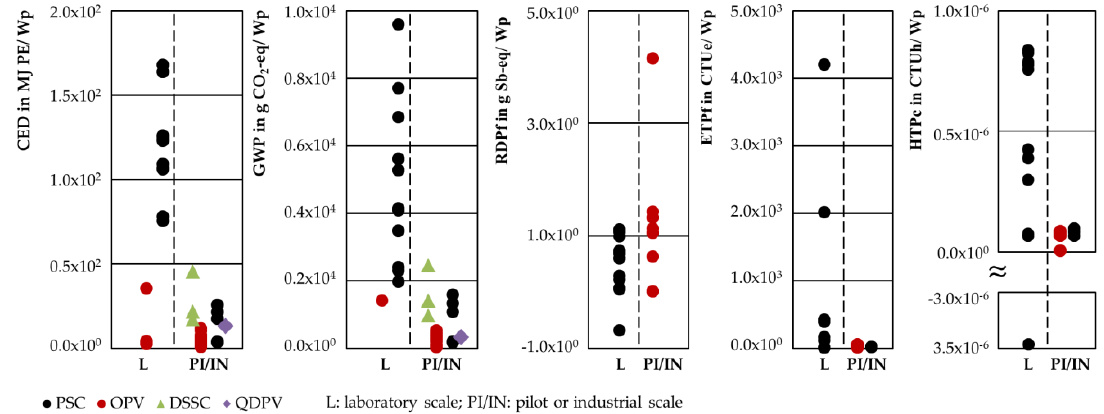
Figure 3. Influence of the technology scale and their single values, laboratory (L) vs. pilot/industrial (PI/IN) scale, on the single harmonized life-cycle assessment (LCA) dataset points of the five